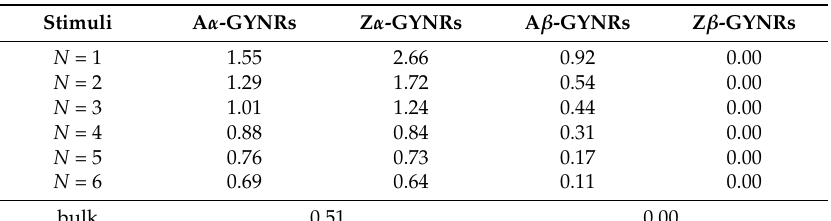
Table 1. The band-gap energies for various configurations of the armchair- and zigzag-edged ( α , β )-GYNRs and the monolayer ( α , β )-graphyne.